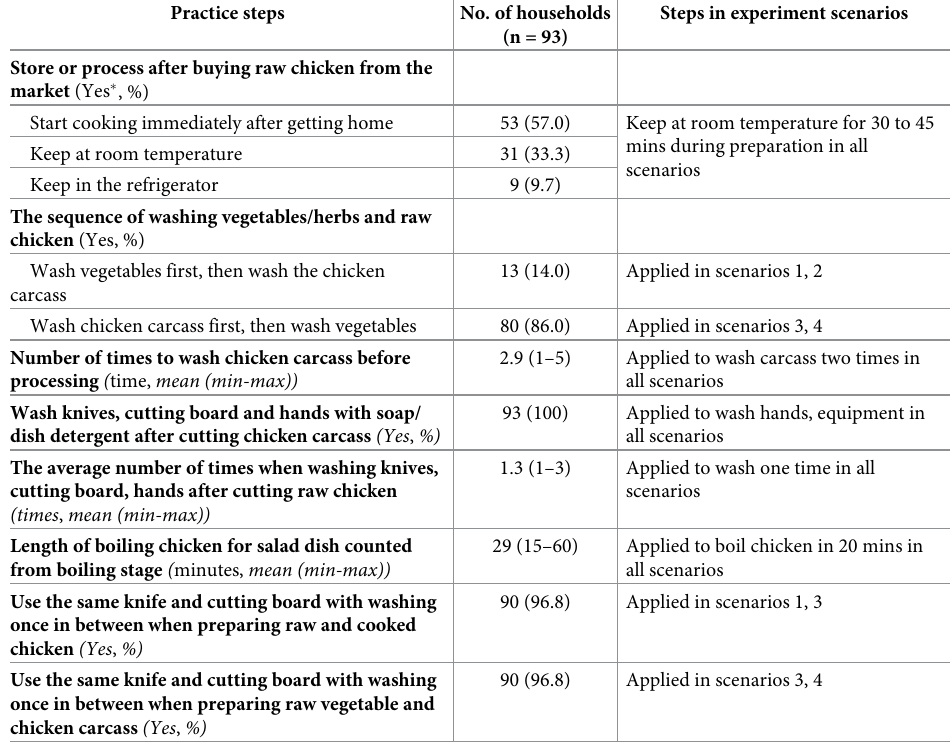
Table 2. Food safety practices for preparing chicken salad in Cambodian households. Practice